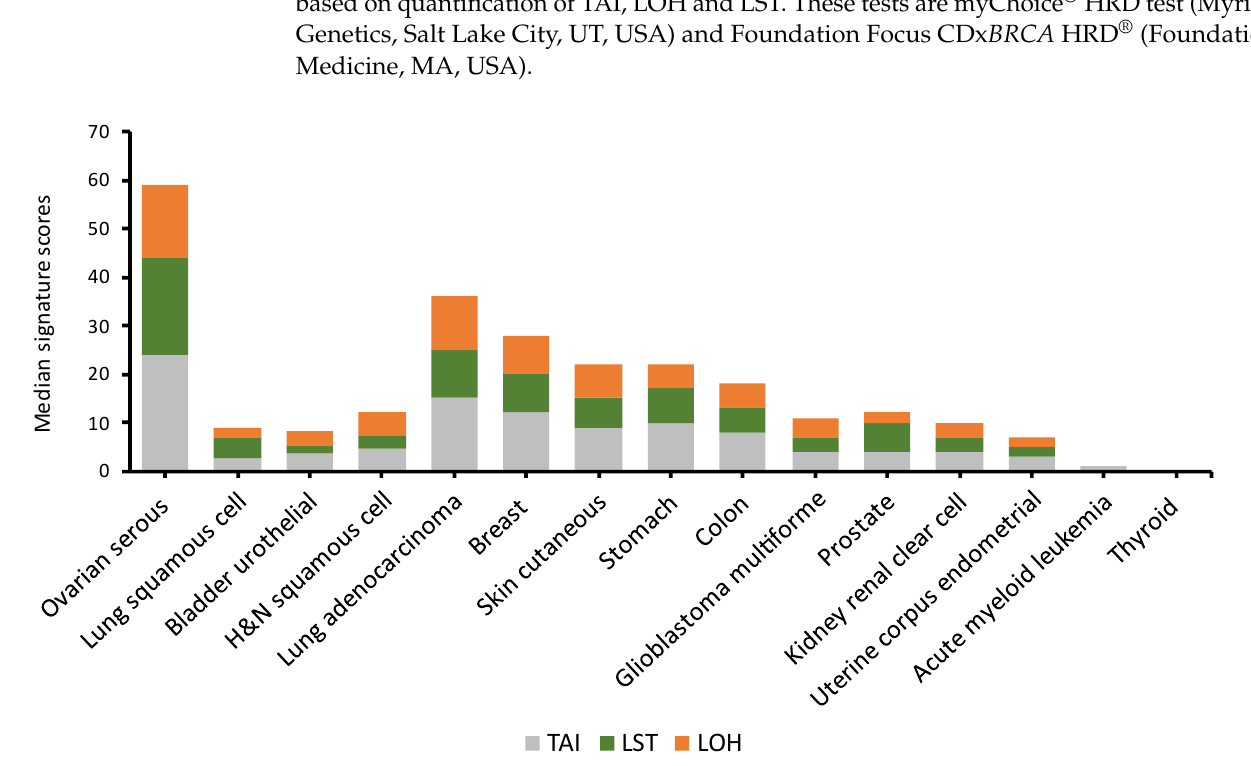
Figure 3. HRD prevalence across different tumor types. Adapted from Marquard et al. [21], copyright 2015 Marquard et al, under the Creative Commons Attribution Non-commercial No Derivatives 4.0 License (https://creativecommons.org/licenses/by-nc-nd/4.0/, accessed on 12 May 2022). The figure has been made for the purposes of this review. HRD analysis of TCGA samples across 15 different cancer types was performed based on the number of Telomeric Allelic Imbalances (TAI) based on a genomic scar accumulation, the large scale transition (LST) based on a type of genomic scar associated with loss of BRCA1 or BRCA2 and the HRD-LOH based on a scar enriched in high- grade serous ovarian cancer patients with a loss of BRCA1 or BRCA2 [21–23]. However, the method originally used for ovarian cancer samples was adapted to avoid bias when the algorithm is applied across different tumors: (1) In the original publication describing TAI [24], all allelic imbalance events that extended to the telomere were counted, if they did not span the centromere. This results in an overrepresentation of tumors with an uneven copy number among high TAI cases, which has been corrected in the method used for the present study. (2) The original publication describing HRD-LOH [23] excluded chromosome 17 because LOH on chromosome 17 in the ovarian cancer samples is ubiquitous and for this reason did not provide independent information. However, for this figure, chromosome 17 was not excluded, as chromosome 17 is not ubiquitously lost in all cancer types, and therefore may provide independent information in some tumor samples. Ovarian cancer has the strongest association with HRD, and up to 50% of high-grade serous ovarian carcinoma have a genetic aberration in the HR pathway [25]. In general, somatic aberrations are twice as frequent as germline alterations [20]. In non-endometrioid TP53-mutant endometrial cancer, which is molecularly similar to high-grade serous ovarian carcinoma, a high incidence of HRD genomic scars of up to 48% has been reported [26]. The prognostic significance of HRD in ovarian cancer is controversial. It has been reported to have more favorable overall survival (OS) compared to non-carriers [27], for both